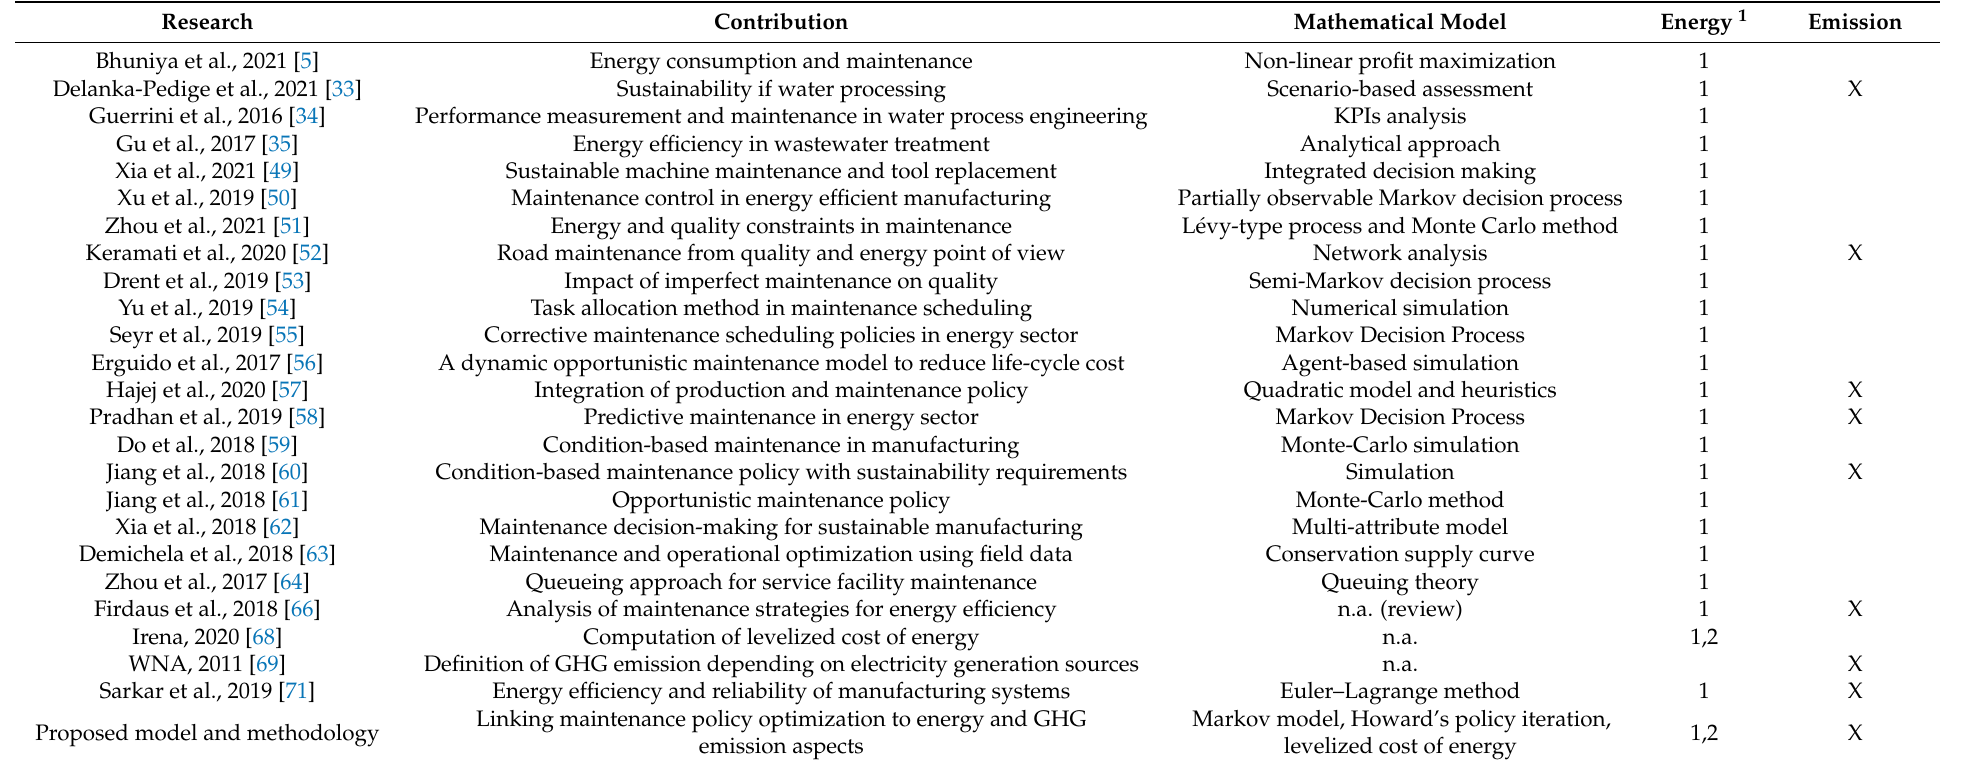
Table A2. Authors’ contributions related to energy and emission aspects of maintenance policy